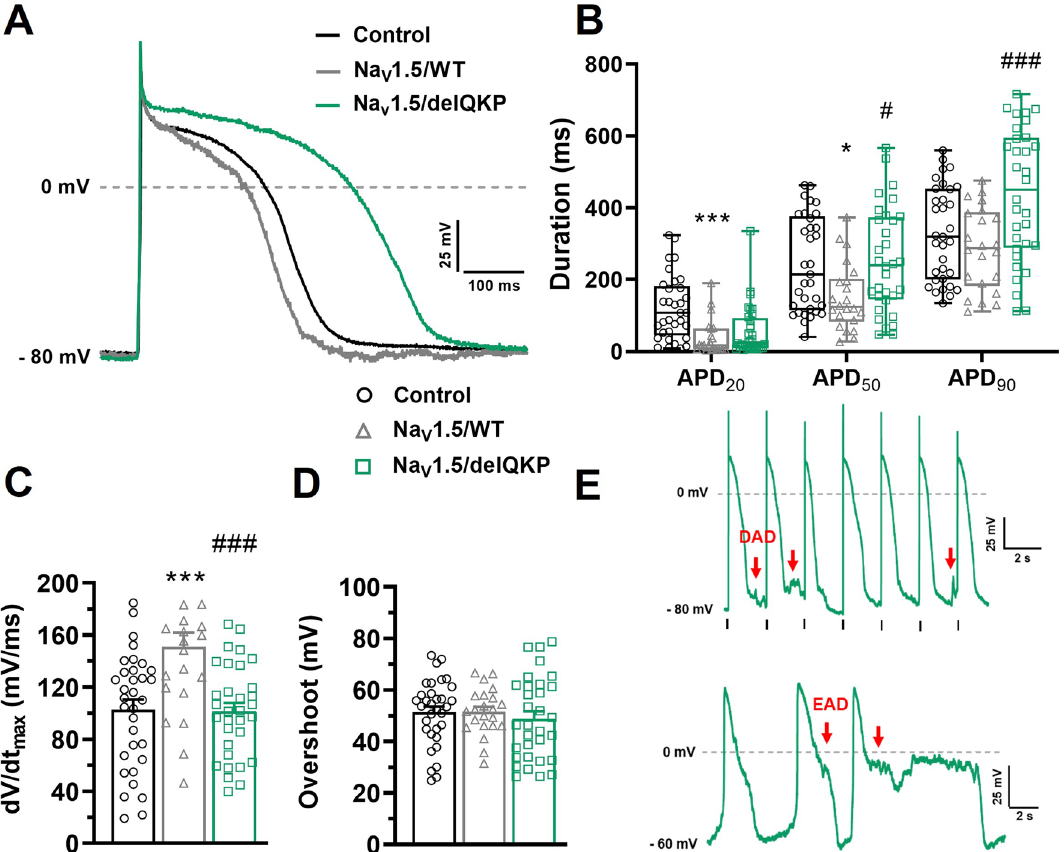
Figure 7. APD prolongation, dV/dt affected and arrhythmogenic events in KO iPSC-CMs expressing Na V 1.5/ delQKP. ( A ) Representative APs traces at a stimulation frequency of 1 Hz recorded in control and KO iPSC- CMs transfected with Na V 1.5/WT or Na V 1.5/delQKP. ( B ) Box and whiskers summarizing the median (with quartiles and min to max values) of APD at 20%, 50%, or 90% of repolarization at 1 Hz. * p < 0.05, *** p <